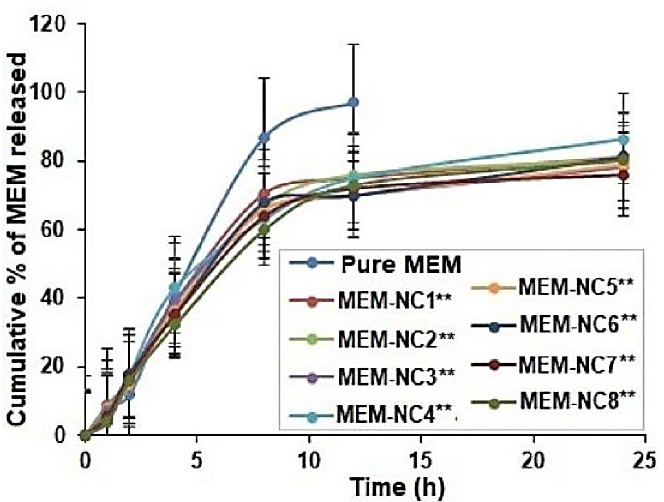
Figure 4. Cumulative percentage of MEM released from various MEM-NCs (mean ± SD, n = 3); the significant variances associated with control (pure MEM) are denoted by ** p < 0.05, as estimated by the ANOVA test.